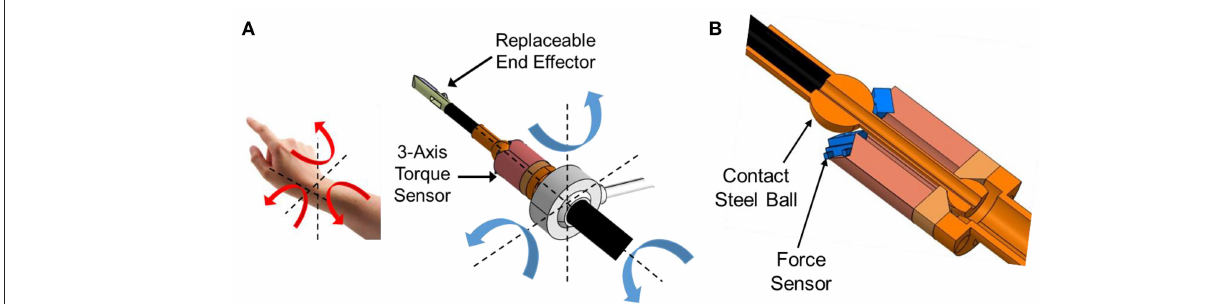
FIGURE 6 | The proposed torque sensor. (A) Configuration. (B) Section view.